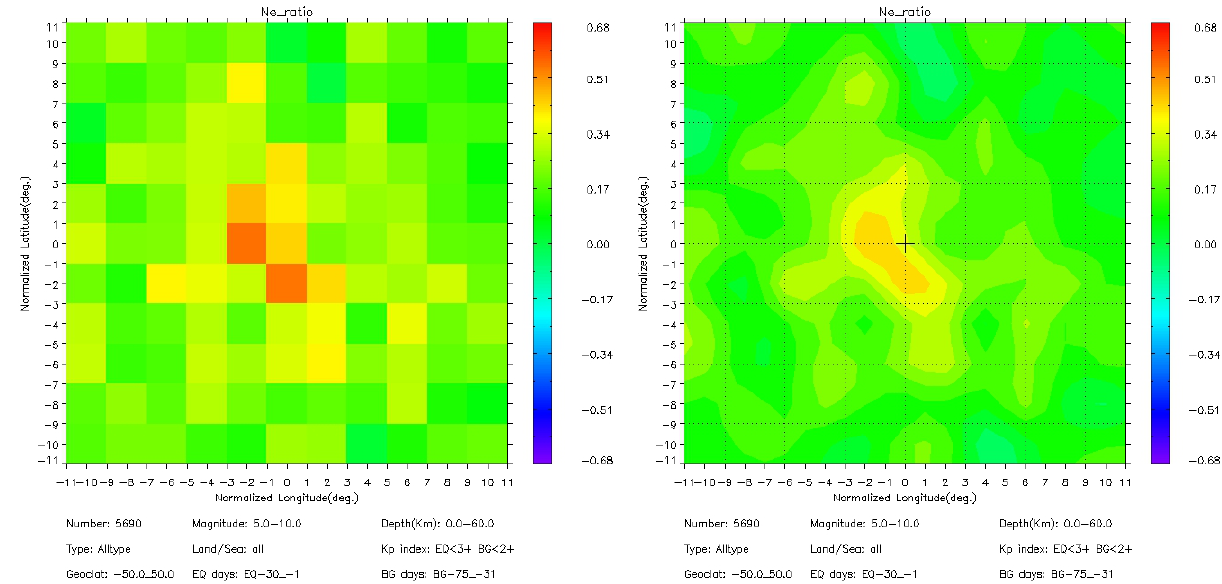
Fig. 2. (Left panel) Statistical results concerning the seismic events on a global scale. (Right panel) Same information as in the left panel but the results have been smoothed. The position 0 in latitude and in longitude corresponds to the location of the epicentres. The values of the parameters given by Eq. (5) are colour coded according to the scale on the right of the panels. The information below the panels is related to the values of the parameters in the earthquake database which have been selected for the current statistic.